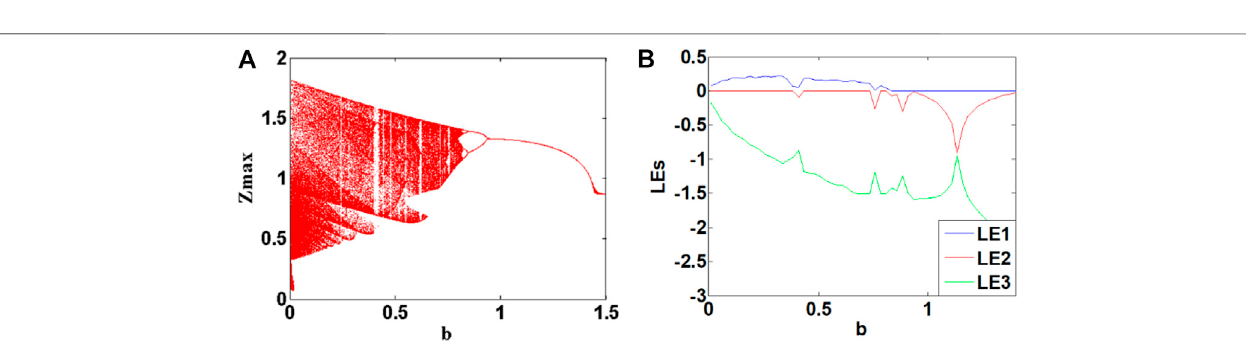
FIGURE 5 | Lyapunov exponents and bifurcation diagrams of system (2) with a (cid:1) 2.4, c (cid:1) 1.7, d (cid:1) 2.5 and initial conditions (1, 0, 1) when the parameter b varies in [0, 1.5]. (A) bifurcation, (B) Lyapunov exponents.